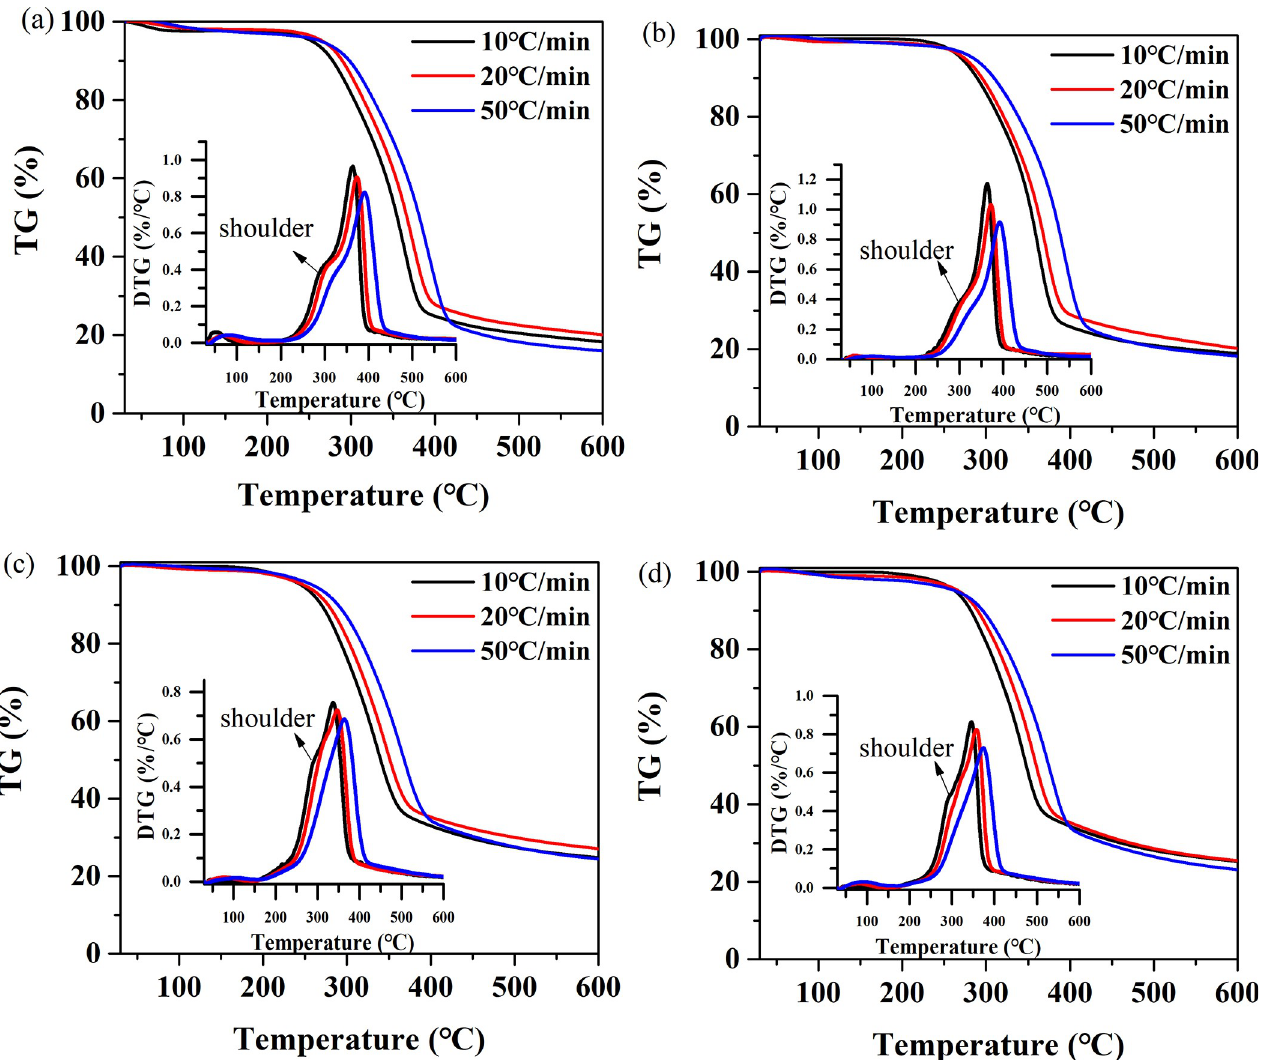
Fig 3. TG-DTG curves at different heating rates. (a) TG-DTG curves for Untreated samples at 10, 20 and 50 heating rates; (b) TG-DTG curves for HT samples at 10, 20 and 50 heating rates; (c) TG-DTG curves for IMPG samples at 10, 20 and 50 heating rates; (d) TG-DTG curves for IMPG-HT samples at 10, 20 and 50 heating